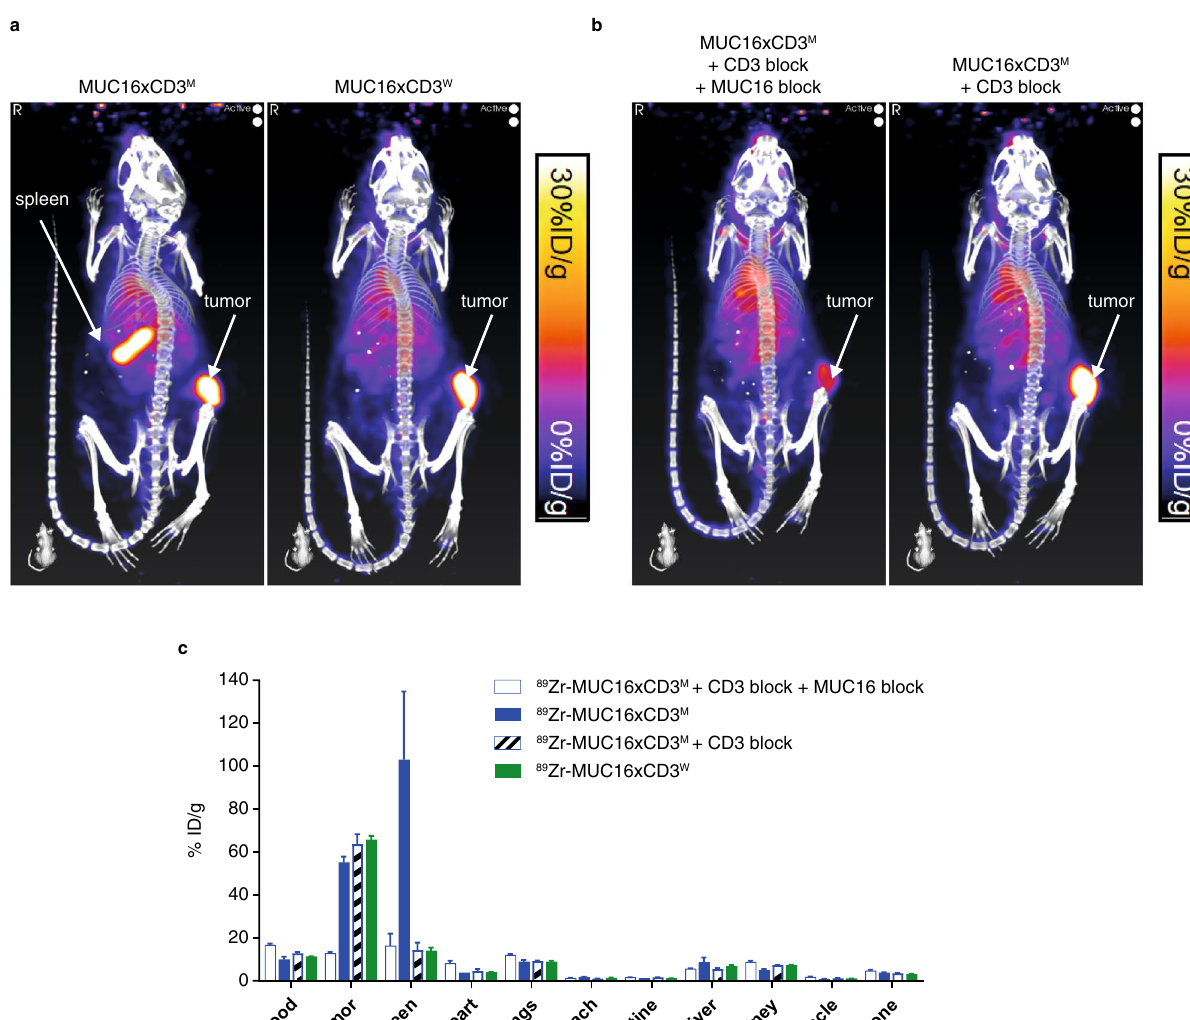
Figure 6. Biodistribution of bispecific T-cell-engaging antibodies is driven by the affinity of their CD3 arm. ( a ) Mice genetically humanized for SIRPA and IL-15 (SRG-15 mice) were implanted with 3 × 10 6 OVCAR-3 ascites cells and 5 × 10 6 human PBMCs and injected with 89 Zr-radiolabeled antibodies at a final dose of 0.25 mg/kg via tail-vein injection when tumors were ~ 100 mm 3 ; immune-PET images demonstrate the in vivo localization of the 89 Zr radiolabeled antibodies 6 days post-dosing ( b ) in a control condition, mice were pre- treated with 10 mg/kg unlabeled bivalent MUC16 antibody and/or 10 mg/kg CD3-binding control antibody was administered in order to block binding of radiolabeled antibodies to MUC16 or CD3, respectively; ( c ) Quantitative ex vivo biodistribution analysis was performed following PET imaging on day 6 post-dosing. The tissue biodistribution values of the 89Zr-radiolabeled antibodies are presented as percent injected dose per gram (%ID/g). 89 Zr Zirconium-89; m , moderate; MUC16 Mucin-16 for ovarian cancer; PBMC peripheral blood mononuclear cell; PET positron emission tomography; SIRPA signal regulatory protein α; vw very weak; w